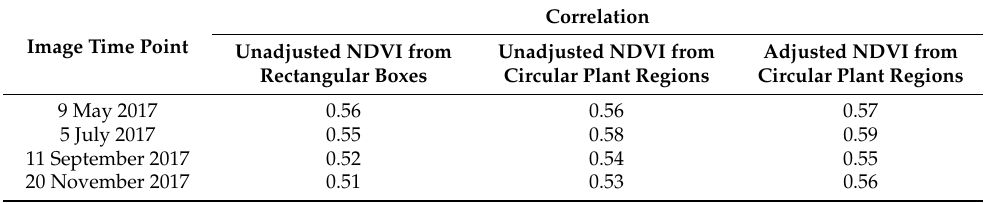
rectangular boxes and proposed circular plant regions: with unadjusted and adjusted NDVI